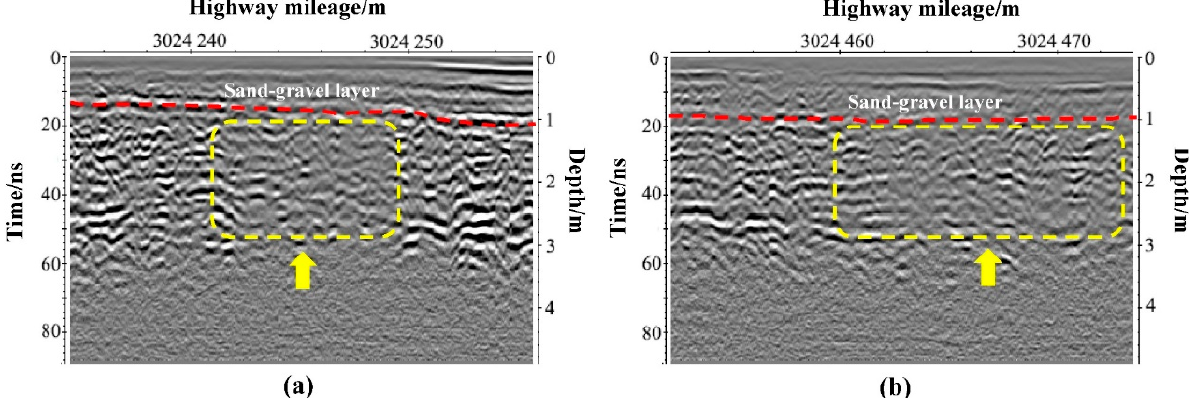
Figure 11. GPR images of an abnormally dense block-stone layer: ( a ) K 3024 + 235 to K3024 + 256; ( b ) K 3024 + 452 to K3024 + 474. The yellow dashed box shows the abnormal area of the block-stone layer, the red dotted line indicates the boundary between the sand-gravel layer and the block-stone layer, and the yellow arrow is used to facilitate reading .